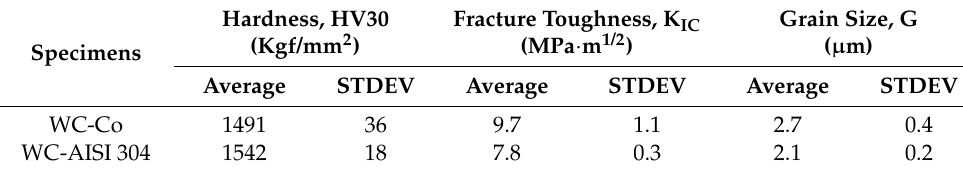
Table 3. Hardness and fracture toughness of WC-Co and WC-AISI 304 specimens (the densification was approximately